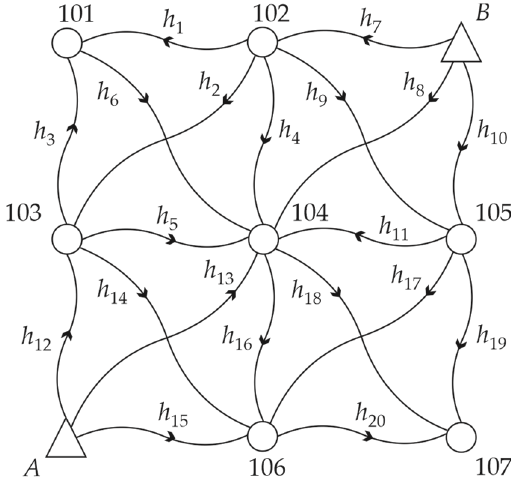
Figure 1. Simulated leveling network.